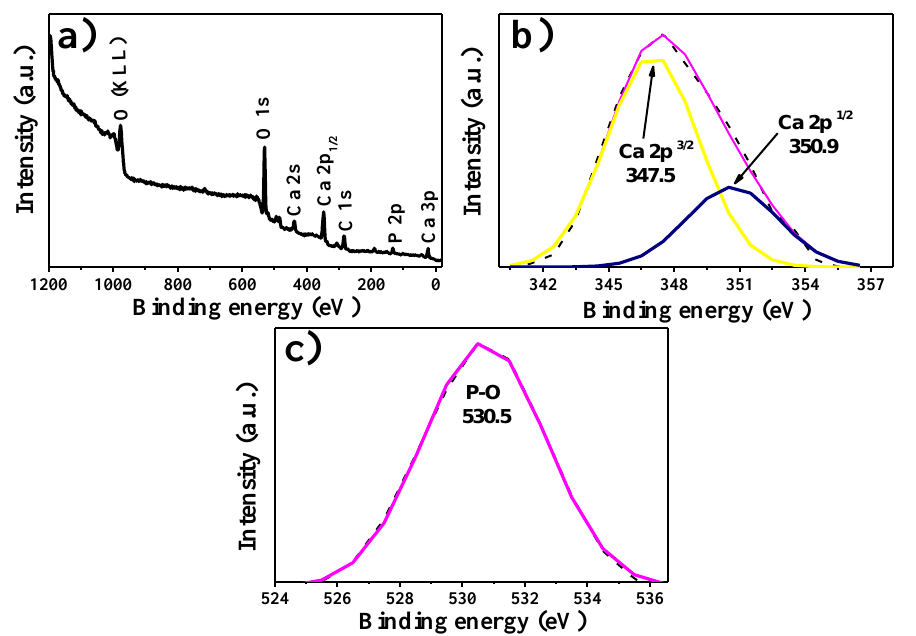
Figure 5. XRD spectrum: ( a ) general spectrum. High-resolution spectra of ( b ) Ca 2p and ( c ) O 1s.